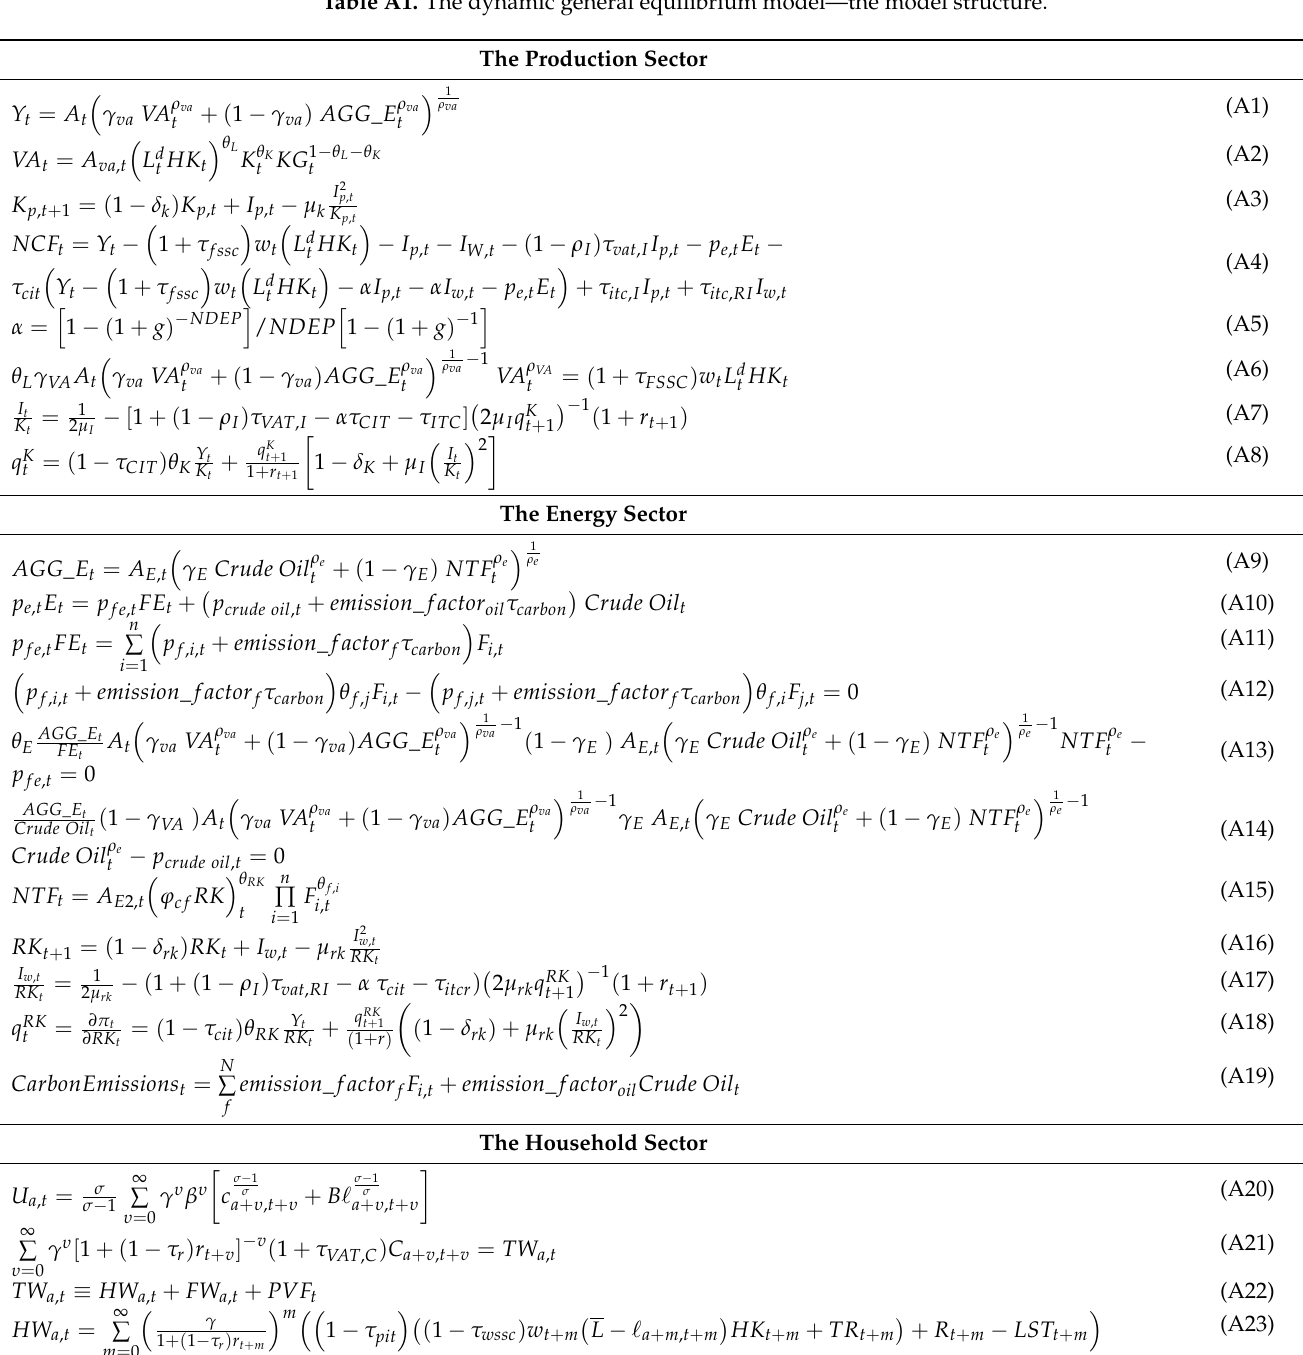
Table A1. The dynamic general equilibrium model—the model